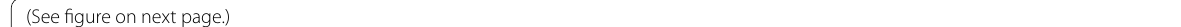
MC EW represents a 25% mepiquat chloride emulsion in water; P n, G s, C i, and T r represent the net photosynthetic rate, stomatal conductance, intercellular CO 2 concentration, and transpiration rate, respectively